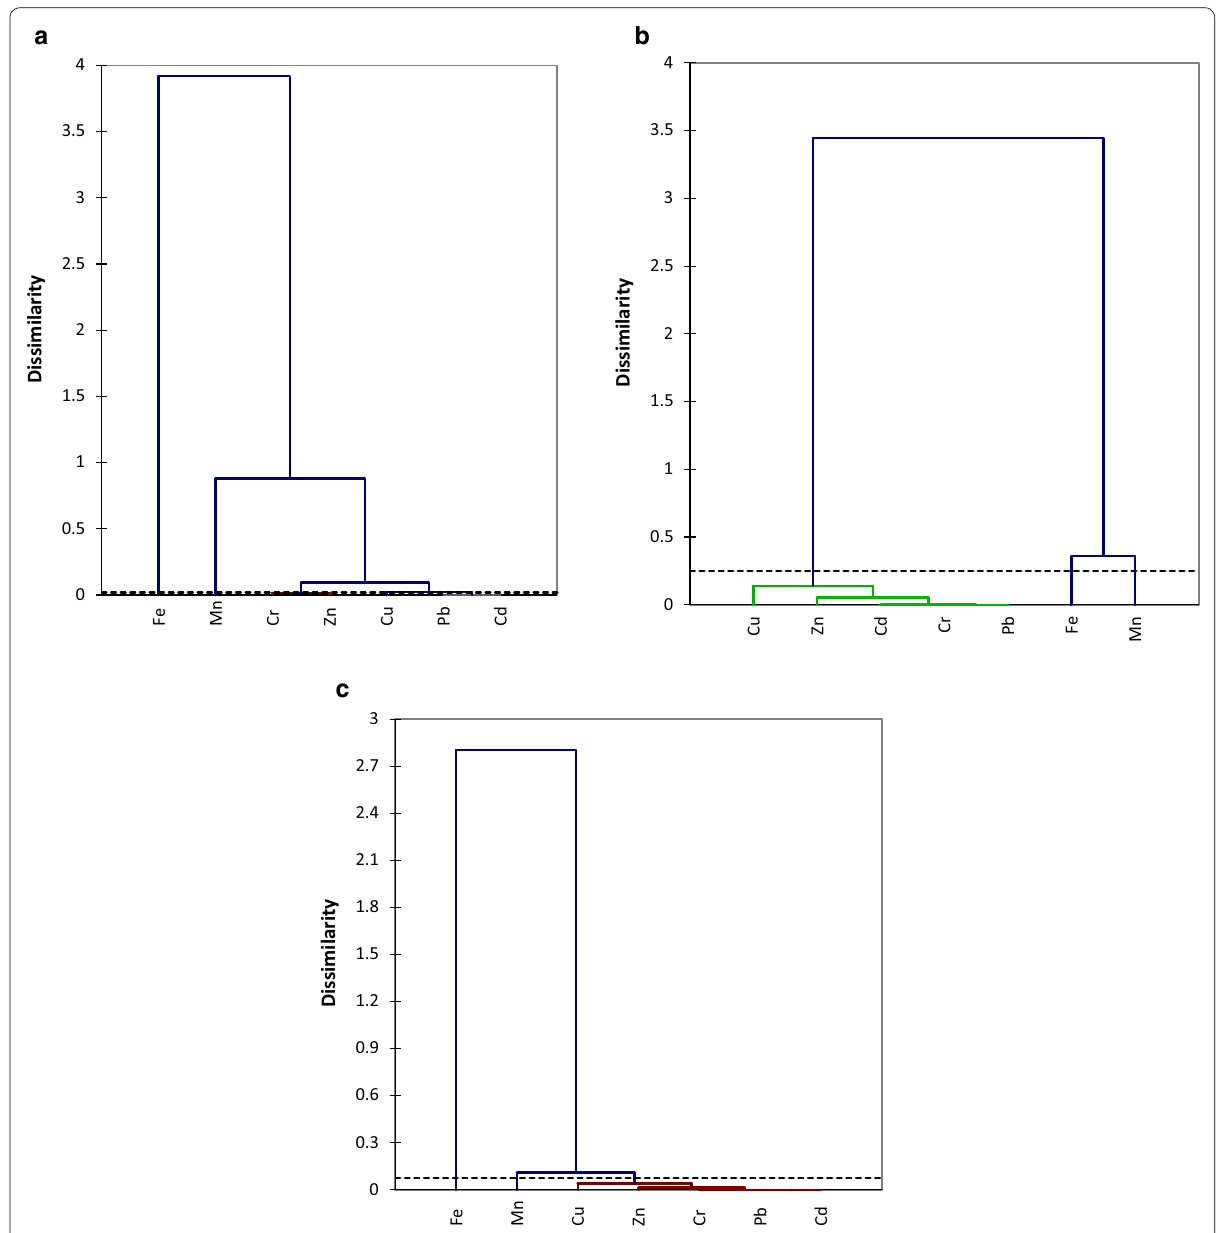
Fig. 3 Dendrogram showing the spatial clustering of selected heavy metals in water samples from Muledane boreholes during the monitoring periods based on the hierarchical cluster analysis using Ward’s